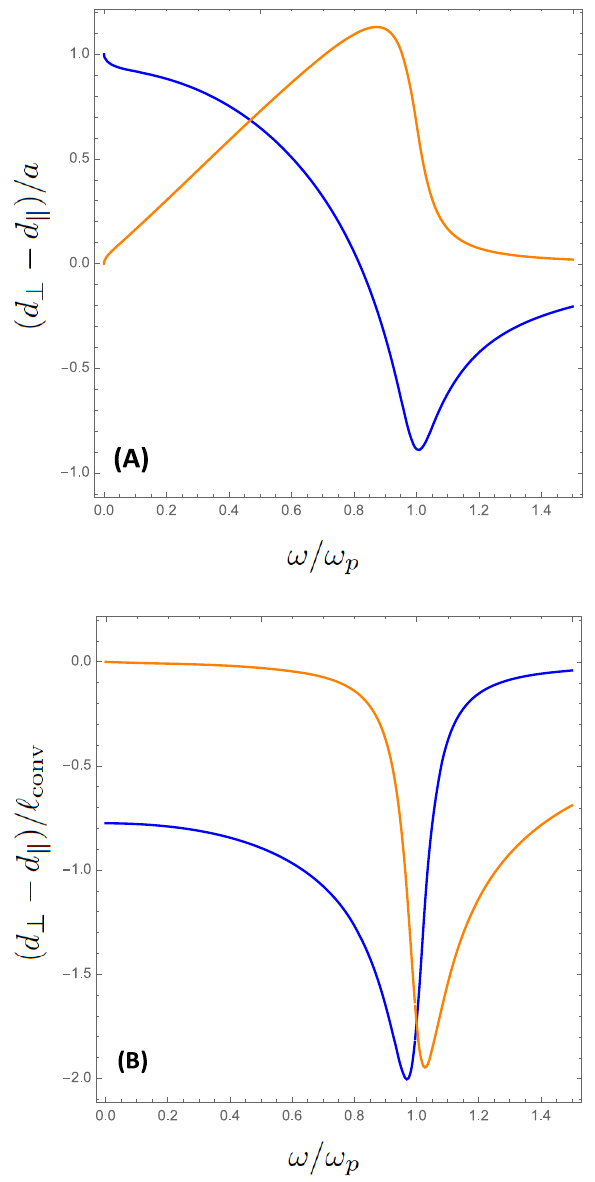
Figure 10: Spectral dependence of the frequency-dispersive effective Feibelman parameter d ⊥ − d ∥ for 𝛾 ∕ 𝜔 real part (in blue) and the imaginary part (in orange) are related through Kramers–Kronig relations. (A) Local-response approximation contribution from a smooth equilibrium electron-density profile, Eq. (35) normalized by a . (B) Nonlocal hydrodynamic contribution, Eq. (36) normalized by 𝓁